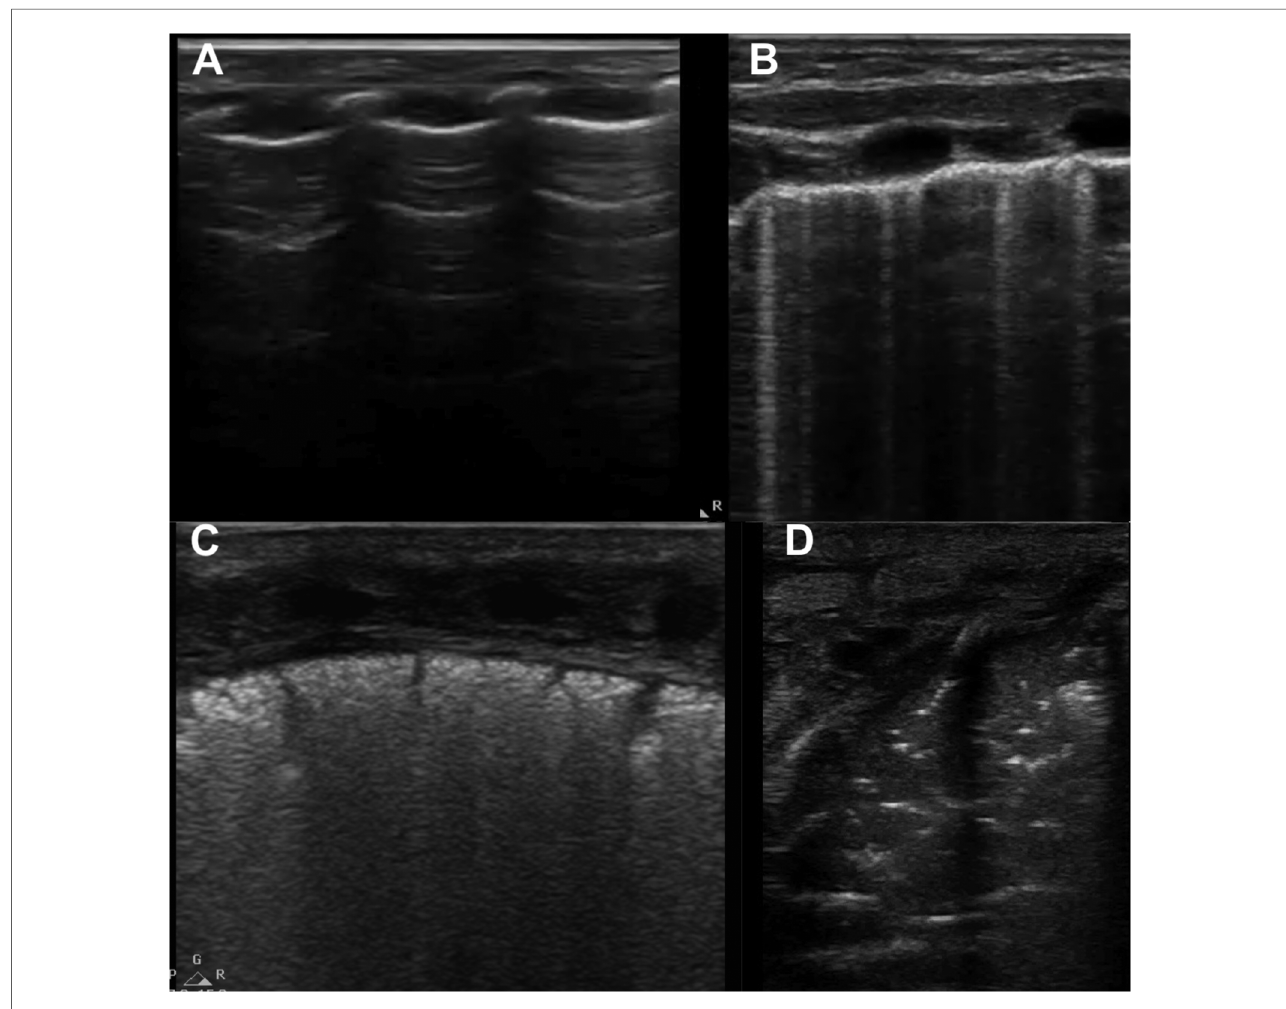
FIGURE 10 Lung ultrasound patterns used to calculate lung ultrasound scores. ( A ) score 0, A-pattern (de fi ned by the presence of only A-lines); ( B ) score 1, B-pattern (de fi ned as the presence of ≥ 3 B-lines); ( C ) score 2, severe B-pattern (de fi ned as the presence of crowded and coalescent B lines with or without consolidations limited to subpleural space); ( D ) score 3, extended consolidation. Modi fi ed with permission from Corsini et al.